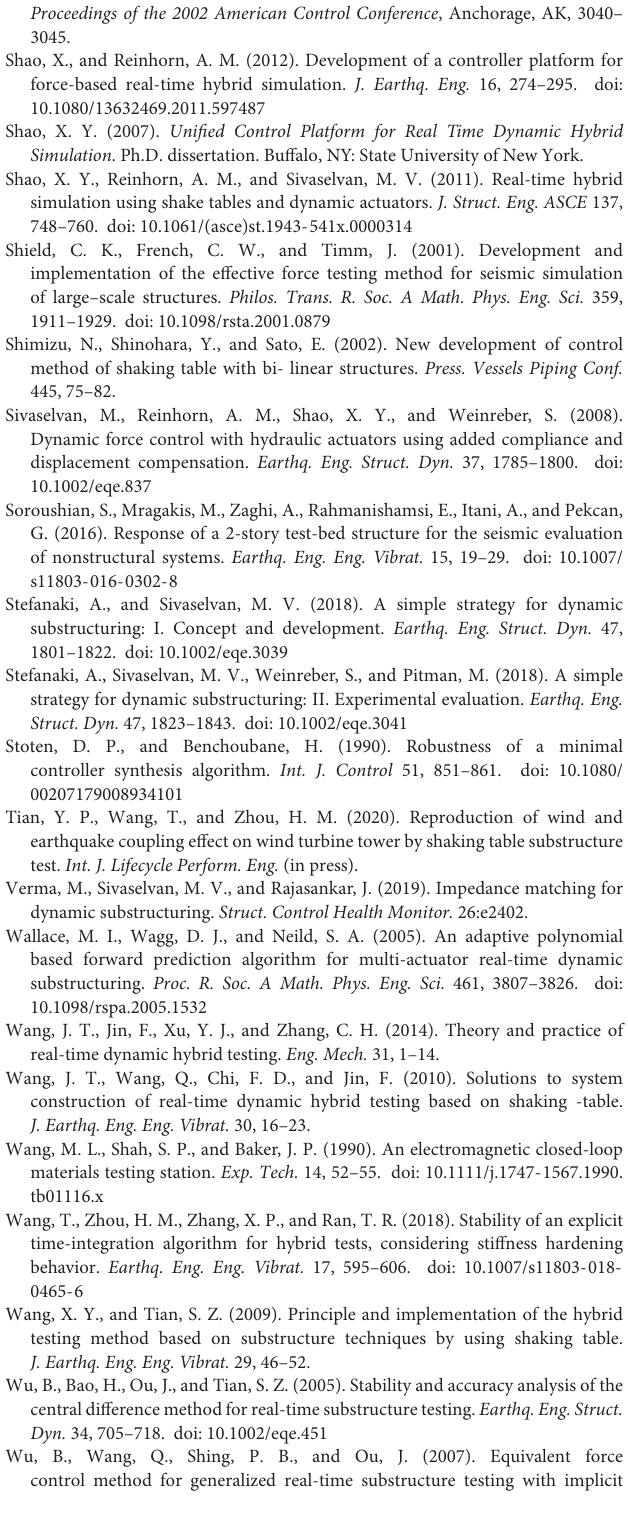
table real-time hybrid simulation techniques for the performance evaluation of buildings with inter-story isolation. Struct. Control Health Monitor. 24:e1971. doi: 10.1002/stc.1971 Zhang, Y., Sause, R., Ricles, J. M., and Naito, C. J. (2005). Modified predictor- corrector numerical scheme for real-time pseudo dynamic tests using state- space formulation. Earthq. Eng. Struct. Dyn. 34, 271–288. doi: